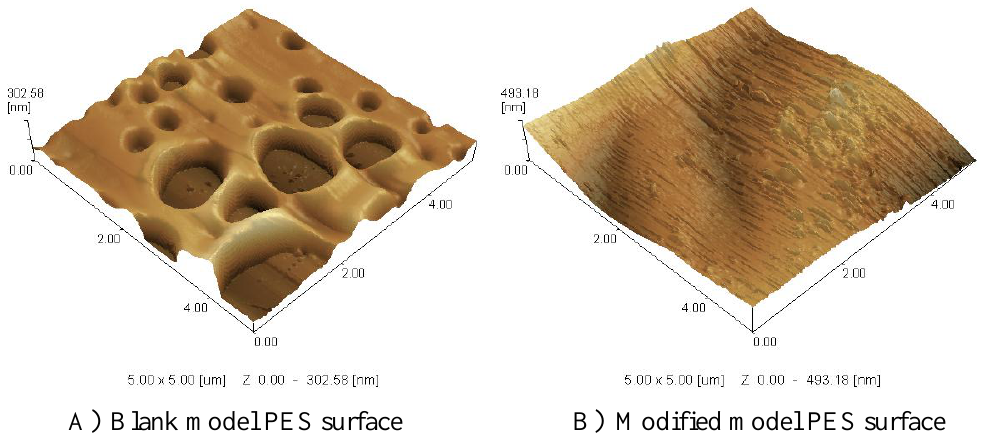
Figure 7. SPM 3D (5 µm × 5 µm) images of PES model surface ( A ) and modified model PES surfaces ( B ) prepared at 10 mM ferulic acid, 0.5 U·mL −1 laccase, 45 °C, pH 5 (0.1 M sodium acetate buffer)